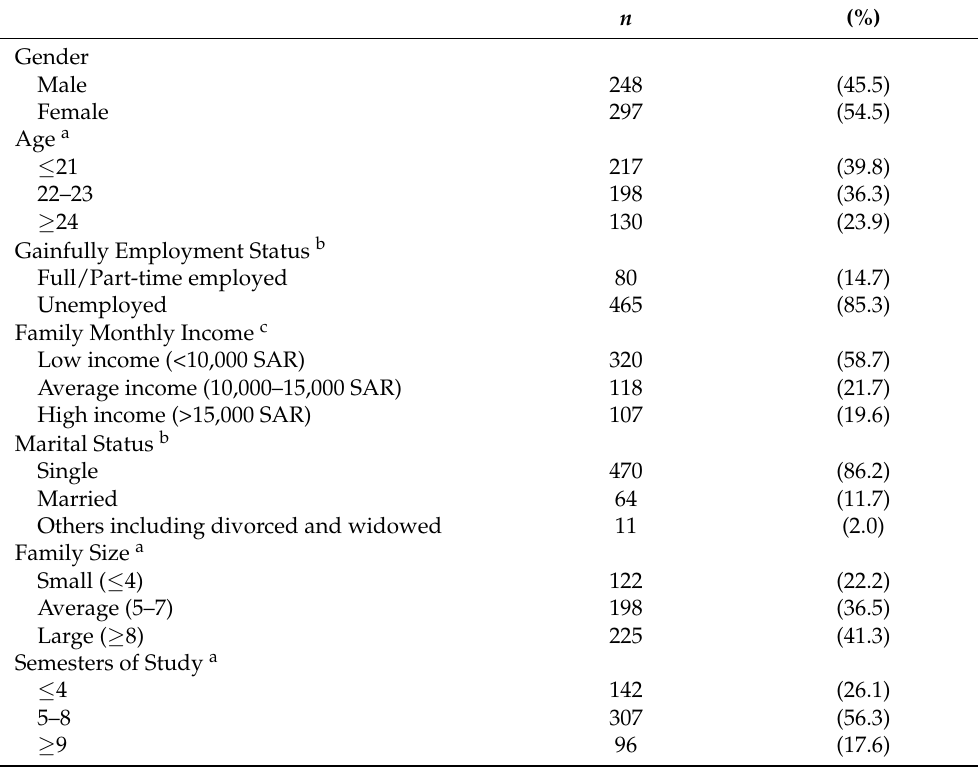
Table 1. Distribution of sociodemographic characteristics, N = 545.